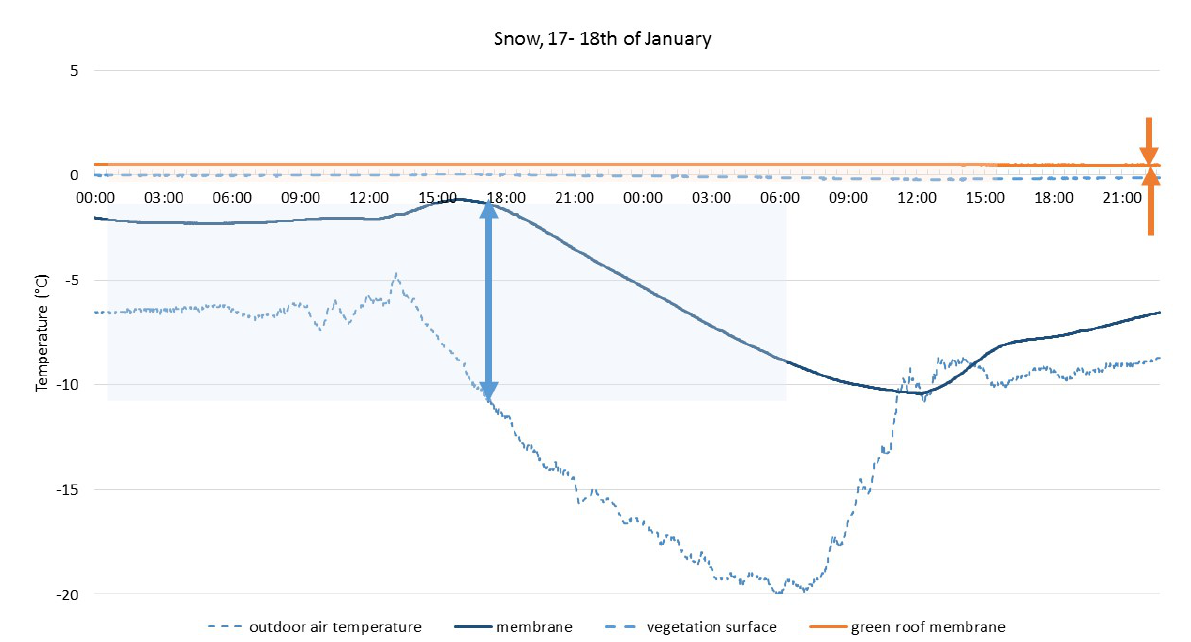
Figure 7. Temperature courses for two days with roof covered by snow. Daily difference on the membrane is 9.2 °C, green roof membrane 0.5 °C. Air temperature difference is 15.3